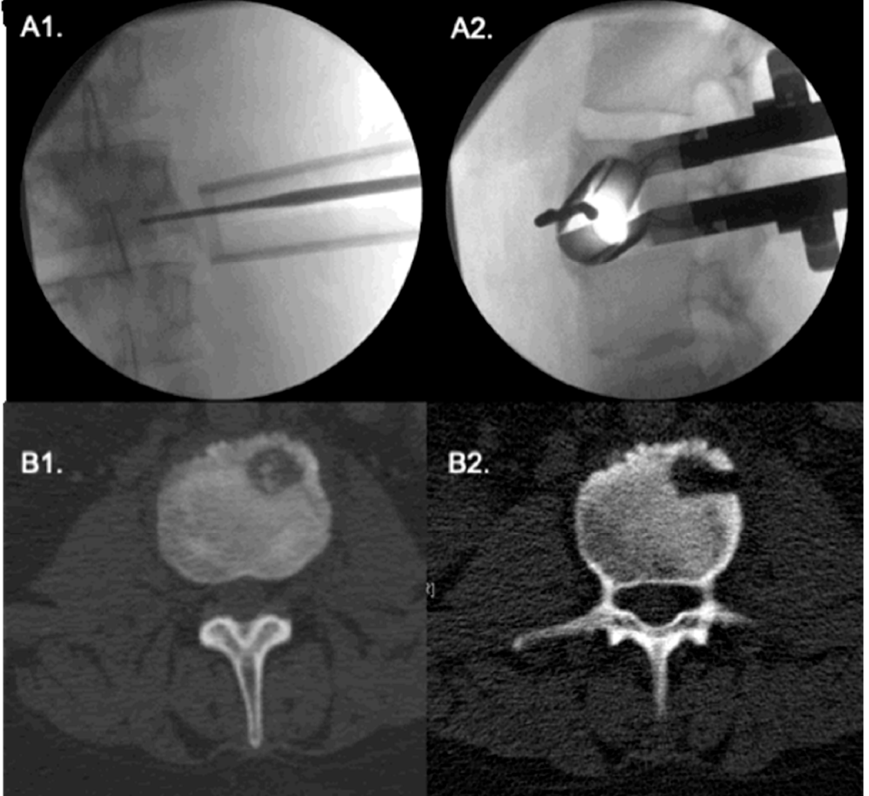
Figure 3. Extreme lateral approach to an L3 vertebral body tumor. ( A1 , A2 ) Antero-posterior and lateral fluroscopy show the correct positioning of tubular retractor; the probe points to the tumor. ( B1 , B2 ) intraoperative CT show the tumor. A pituitary forceps is shown inside the lesion.